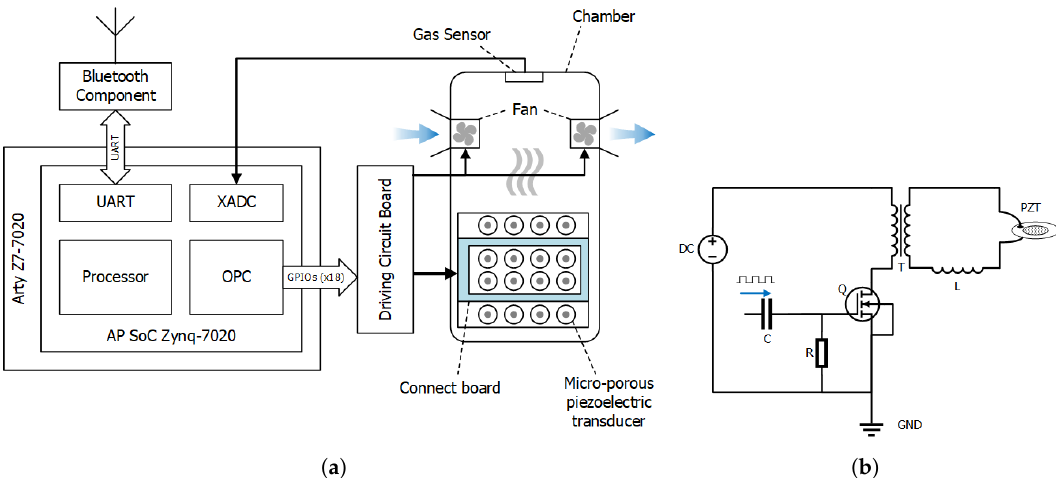
Figure 3. Hardware design. ( a ) Architecture of the odor reproduction system (ORS) design; and ( b ) the wave amplifying